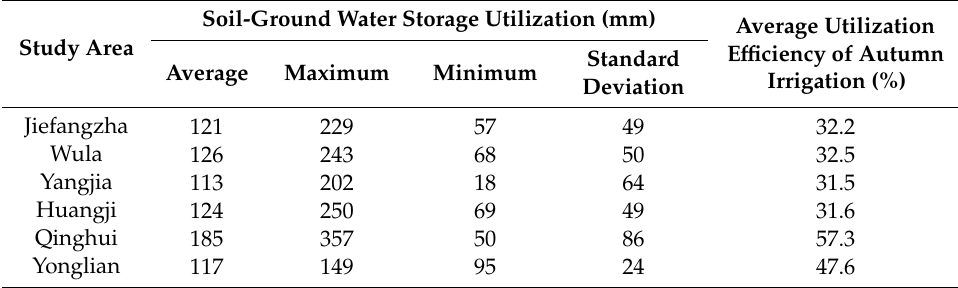
Table 2. Statistical results of soil-ground water storage utilizations and utilization e ffi ciency of autumn irrigation of Jiefangzha and its four subareas, and Yonglian.